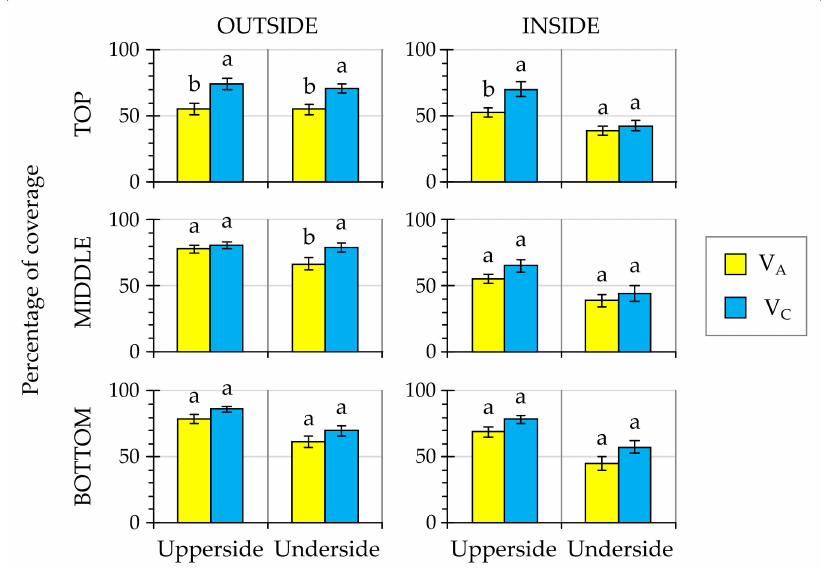
Figure 3. Spray coverage (%) (mean value with standard error bar) obtained on the upperside and underside of leaves at three heights (top, middle, bottom) of the outside and inside parts of clementine tree canopies after application of conventional (V C ) and adjusted (V A ) volume rates considering the 13 evaluations in the orchards on seven locations over the years 2016 and 2017. Different letters above the bars within each height × depth × leaf side combination indicate significant differences (LSD test, p <